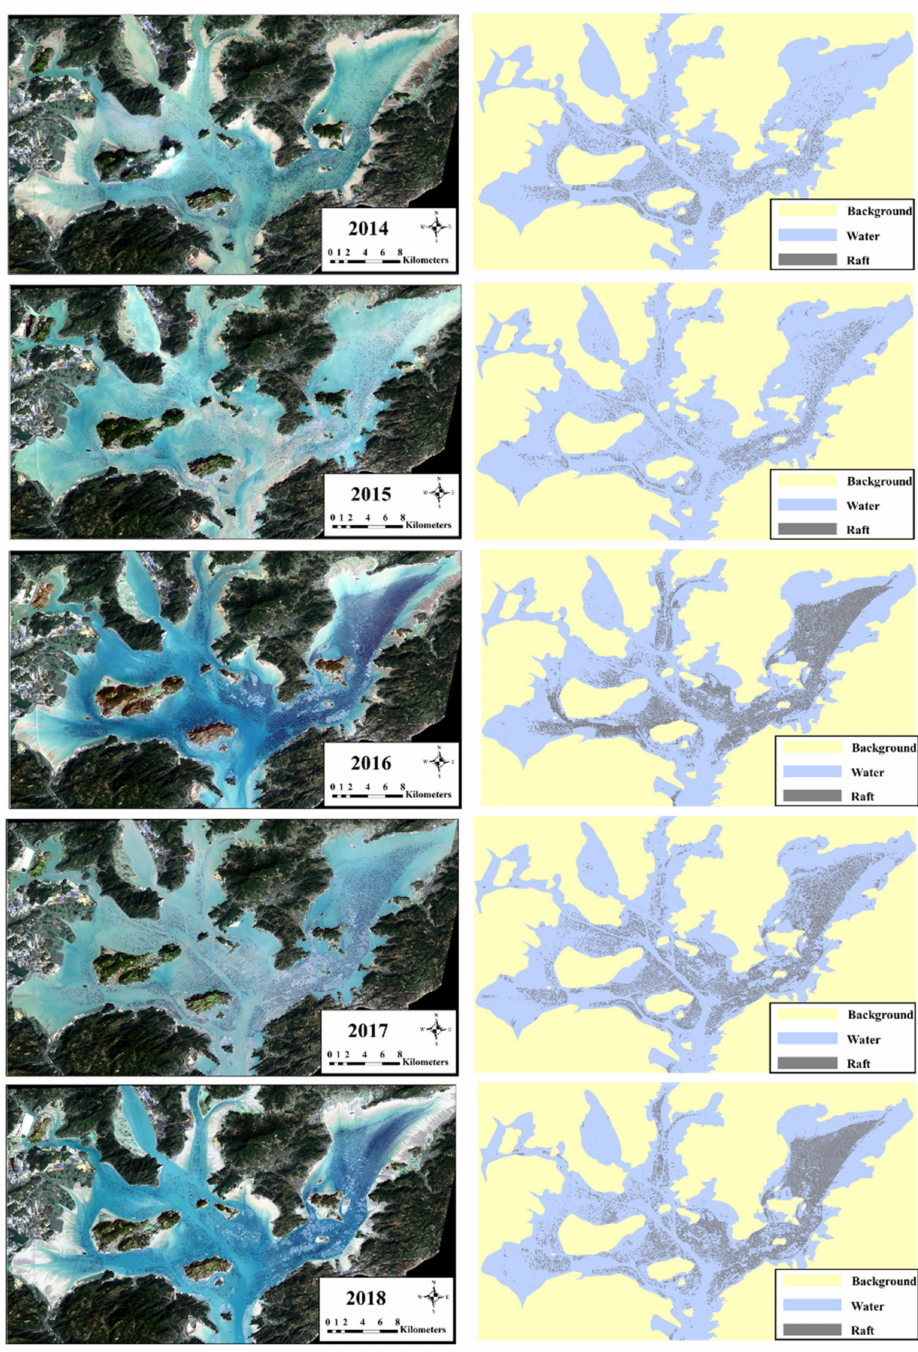
Figure 10. Sansha Bay raft extraction map from 2014 to 2018. The left plots are the original images, and the right plots are the corresponding extraction results. The yellow color indicates the background, blue color indicates the sea water, and gray color indicates the